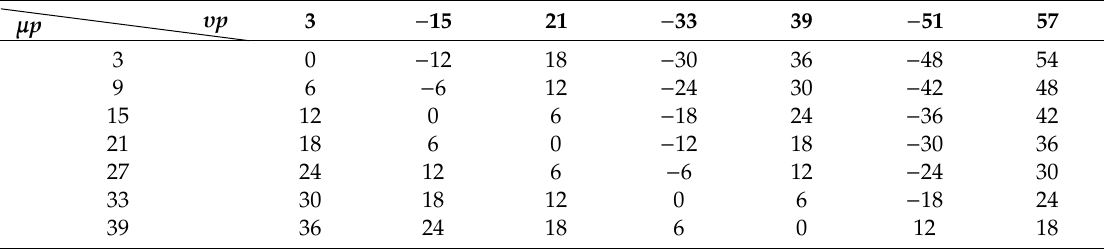
Table 2. Order of radial electromagnetic force wave of prototype